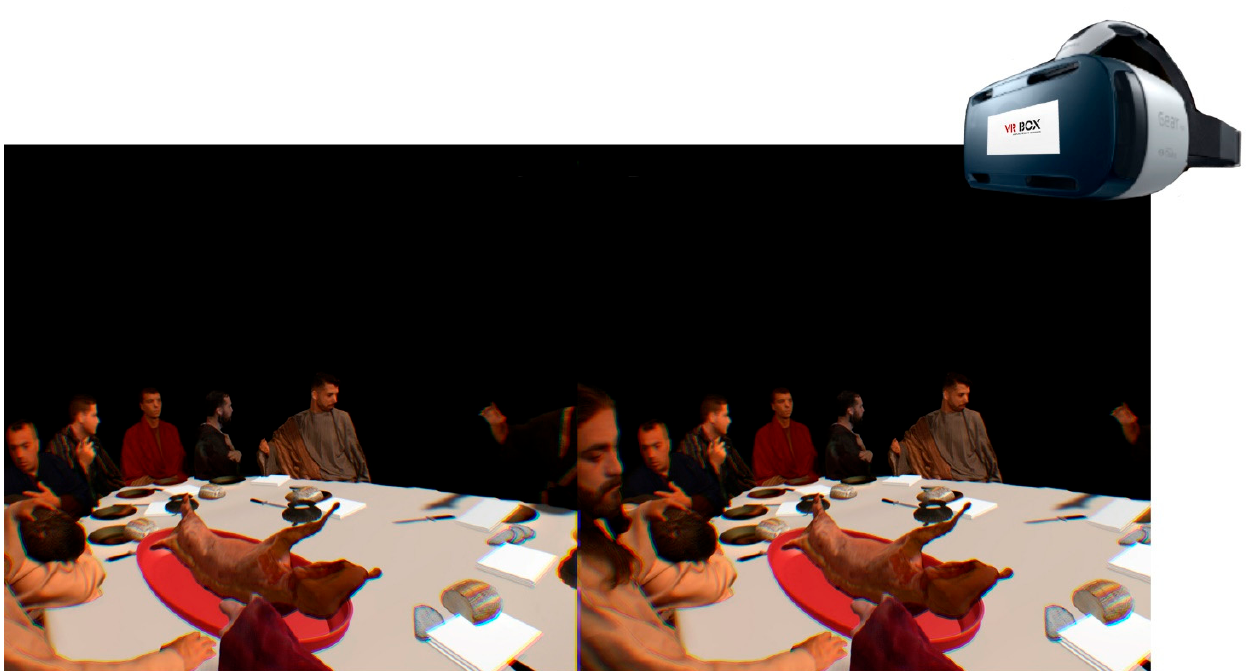
Figure 22. Seen through the stereoscopic use of the VR viewer.